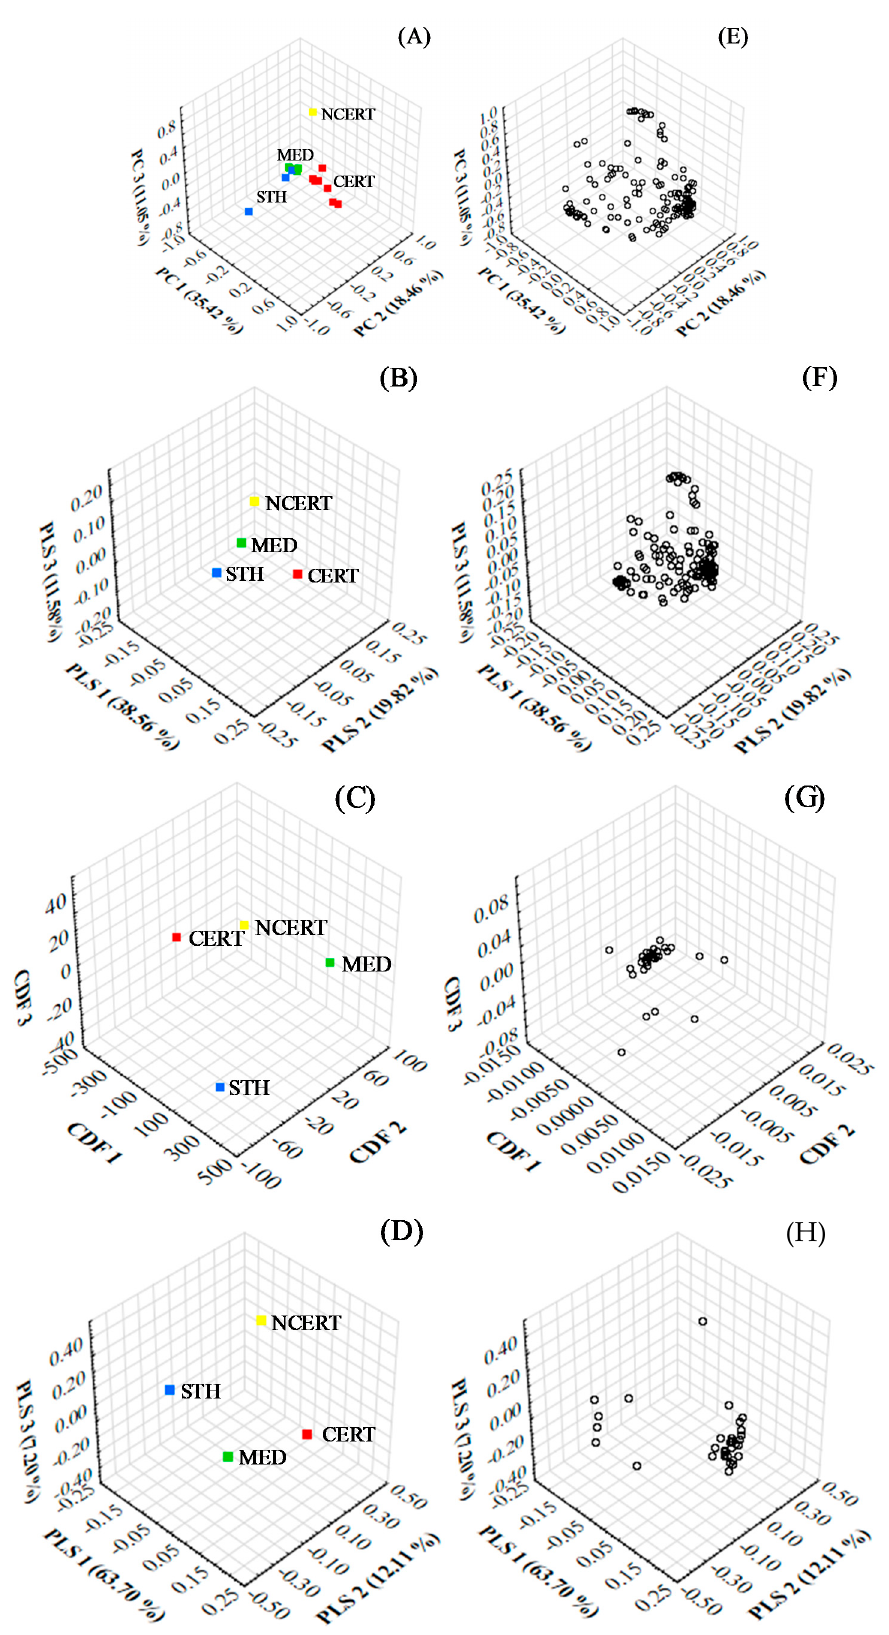
troids are listed in Table S10. The scores values of samples are summarized in Table S11. The PCA line plot based on loading values of samples for the three main components are presented in Figure S2a–c, respectively. The PLS line plot based on loading values of four centroids for the three main components are shown in Figure S2d–f. The PCA 3D plots based on loading values of all samples and the VOCs for the three main components are shown in Figure 3a,e, respectively. The PLS 3D plots based on loading values of the four centroids and the VOCs for the three main components are shown in Figure 3b,f, respec- tively.